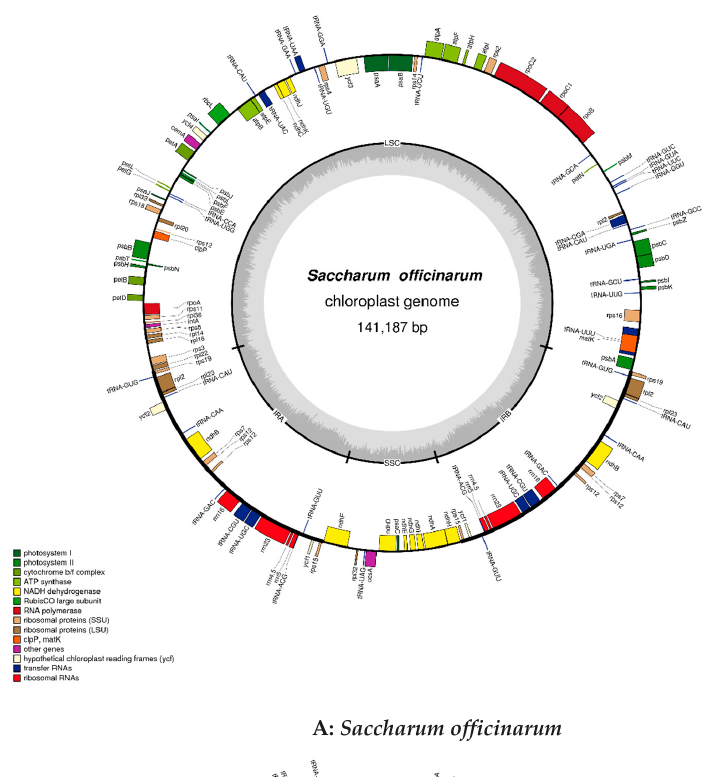
the coding genes; Purple box: tRNA; Orange box: rRNA; Green ring: the coverage depth, of which reverse repeat area is generally two times than that of other areas; Inner circle: GC content of the genome, of which green line representing greater than 50%, and blue for smaller than 50%.